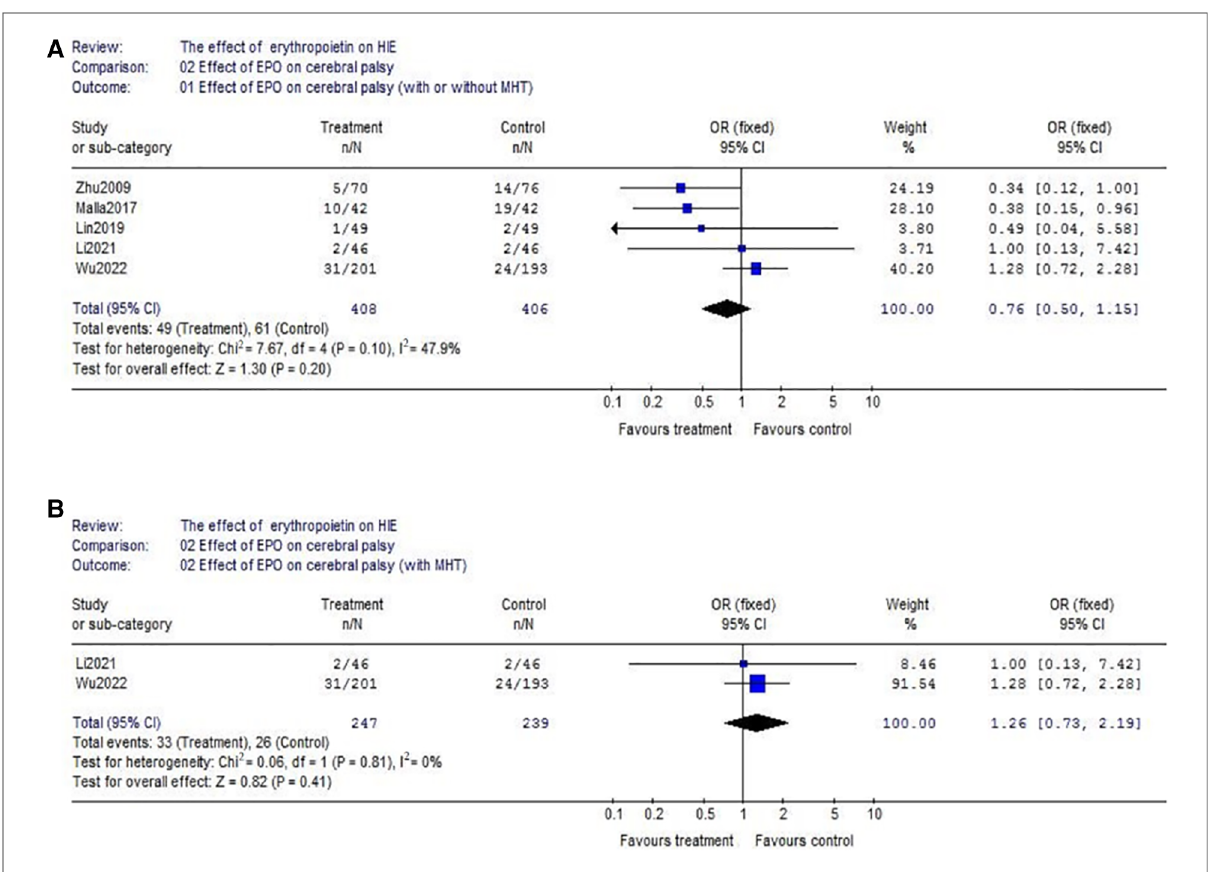
FIGURE 4 The comparison of effectiveness of EPO treatment on cerebral palsy. ( A ) Effect of EPO on cerebral palsy (with or without MHT); ( B ) Effect of EPO on cerebral palsy (with